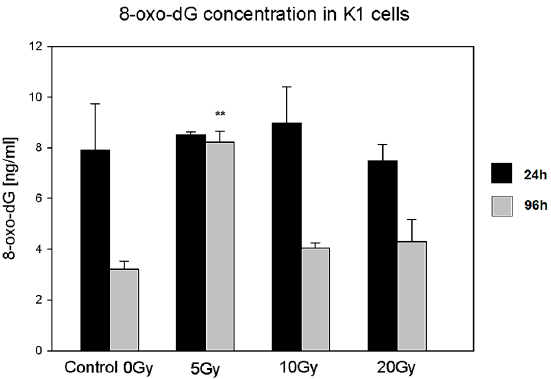
Figure 5. 8-Oxo-dG concentration in K1 cells cultured with 131 I. The graph presents 8-oxo-dG concentration (ng/mL ± SD) in cultured K1 cells directly after 24 h of 131 I exposure (5, 10, 20 Gy) or after additional 72 h of culture without 131 I (** p < 0.01).